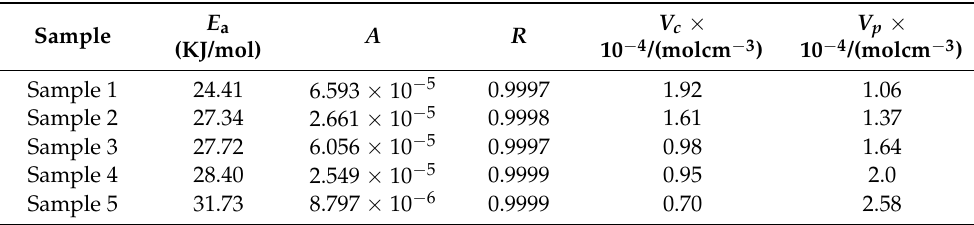
( b ) Figure 10. Variation of physical crosslinking density ( a ), chemical crosslinking density ( b ) with tem- perature for pseudo-semi IPNs. Table 3. Correlation coefficients as well as V c and V p constants obtained by experiments and theo- retical calculation. Sample